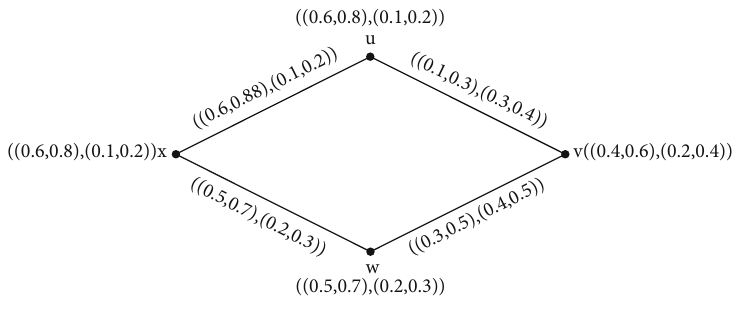
Figure 8: G is SETI-IVIFG but it is not SEI-IVIFG.